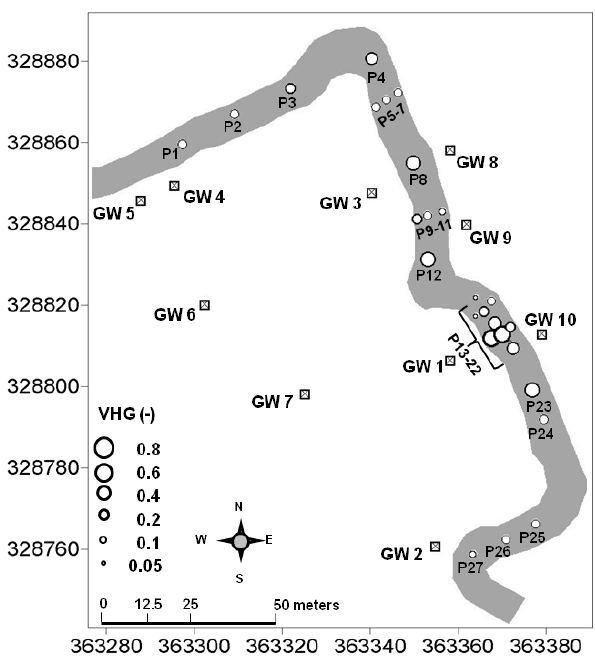
Fig. 6. Spatial patterns of average vertical hydraulic gradients at streambed piezometers (P) for 7 sampling dates between 21 May– 30 September 2009 (see Table 1 for the exact dates).